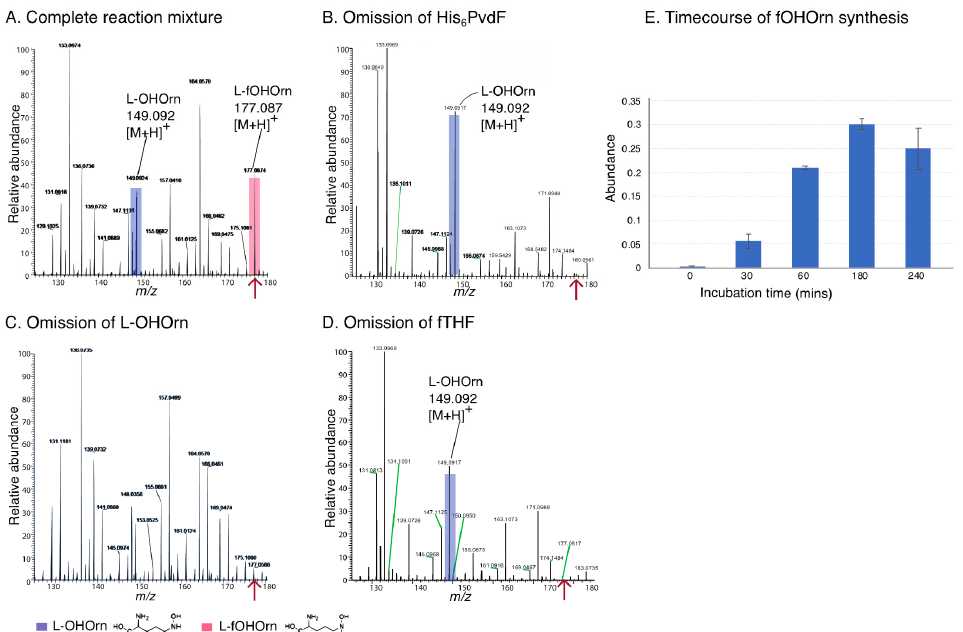
Figure 2. PvdF catalyses synthesis of fOHOrn from OHOrn and N 10 -formyltetrahydrofolate (fTHF). Reaction mixtures containing OHOrn (hydroxyornithine), N 10 -fH 4 F and His 6 PvdF were incubated at 30 °C for 3 h and analysed by direct injection mass spectrometry. Spectra present relative peak intensities of ionised molecules in a range of mass to charge ratios ( m / z ) from 125 to 185. ( A ) His 6 PvdF reaction showing peaks corresponding to OHOrn ([M+H] + 149.0921 ± ppm; blue) and fOHOrn (formylhydroxyornithine) ([M+H] + 177.0870 ± 3 ppm; red). ( B ) Negative control with omission of His 6 PvdF. ( C ) Negative control with omission of OHOrn. Note the background peak at m/z 177.0566 is not related to the fOHOrn peak at m / z 177.0870 (delta m / z > 170 ppm). ( D ) Negative control with omission of fTHF. ( E ) Timecourse of fOHOrn synthesis. Assays were set up in technical triplicates at 0, 30, 60, 180 and 240 min. Abundances of L-fOHOrn were obtained and the average of three technical replicates is shown as a function of incubation time. The error bars are standard errors of the mean. Spectra are representative of at least three independent enzyme